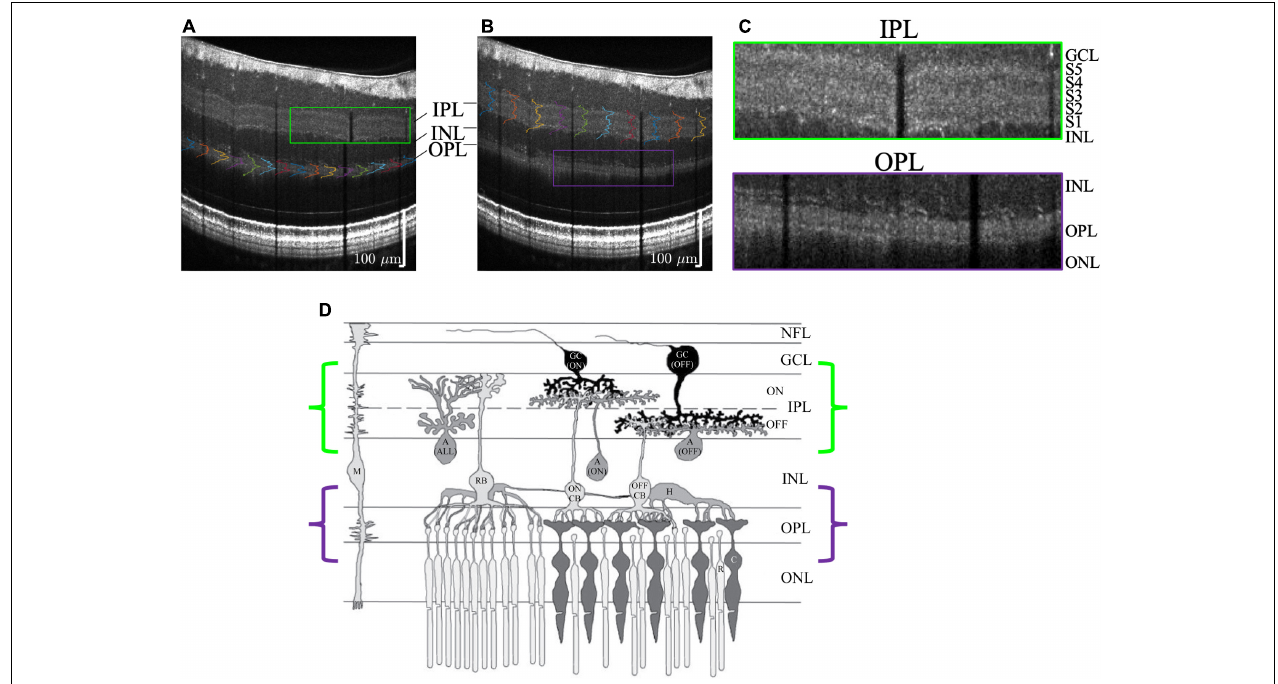
FIGURE 10 | Visualization of outer plexiform layer (OPL) lamination (A) and inner plexiform layer (IPL) lamination (B) in the same high quality visible light OCT image. (C) Zooms show a pentalaminar IPL reflectivity pattern (green outline) and a trilaminar OPL reflectivity pattern (purple outline). (D) Anatomical diagram (reproduced with permission Wang et al., 2003) of retinal circuitry depicts ON-OFF IPL stratification and rod-cone OPL stratification, where the rod spherules are outer to the cone pedicles. Note that the diagram is drawn with bottom-up processing for consistency with the OCT image display (GC, ganglion cell; A, amacrine cell; M, Müller cell; H, horizontal cell; CB, cone bipolar cell; RB, rod bipolar cell; C, cone; R, rod).